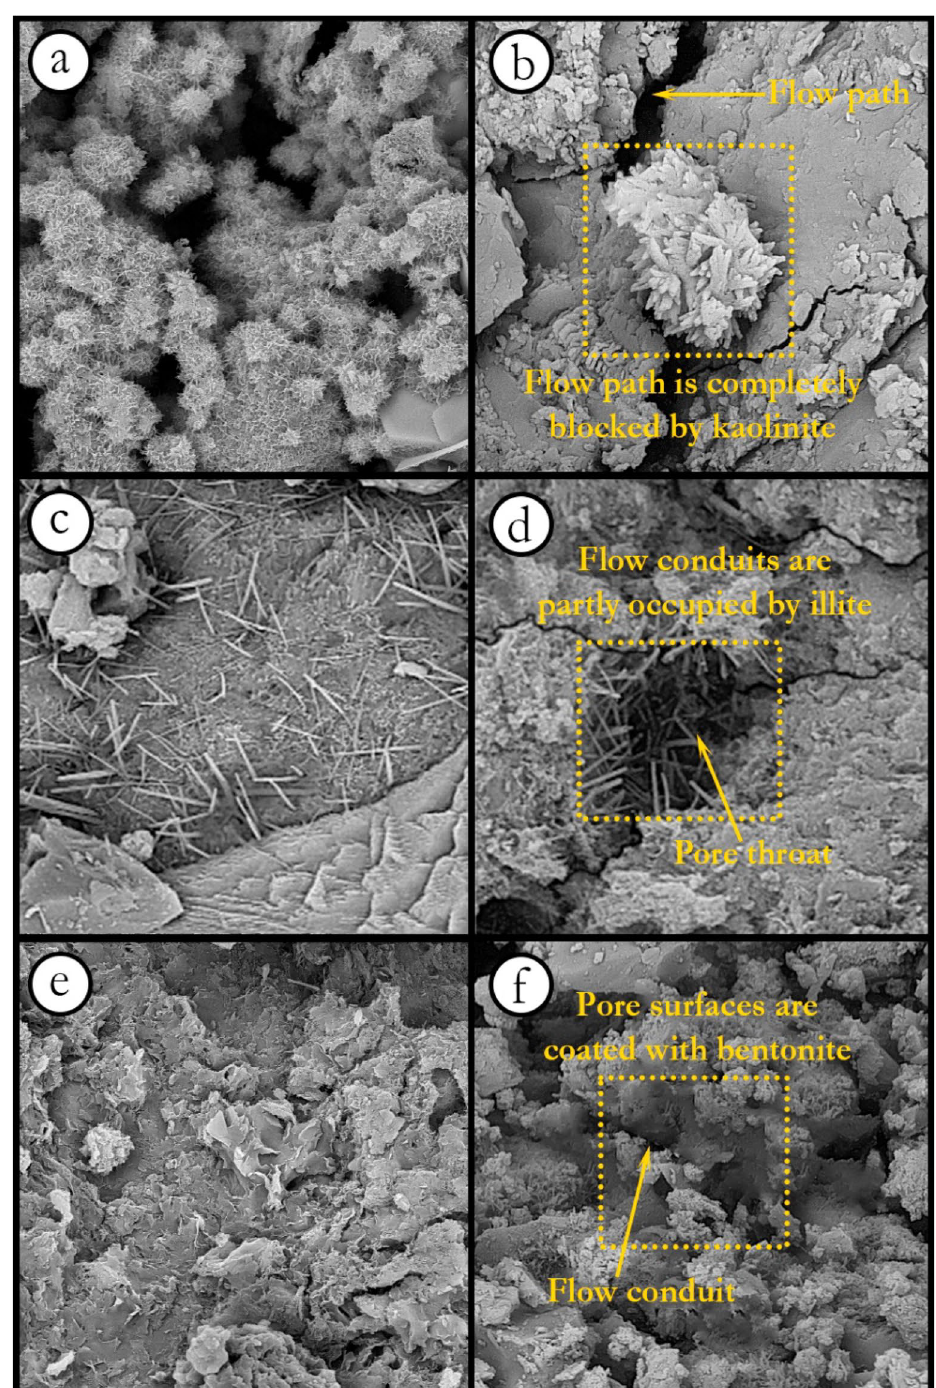
Figure 7. FESEM images of samples containing ( a ) kaolinite, ( c ) illite, ( e ) bentonite (view field: 28.9 µm), and magnified images showing fluid paths ( b ) kaolinite, ( d ) illite, and ( f ) bentonite (view field: 9.63